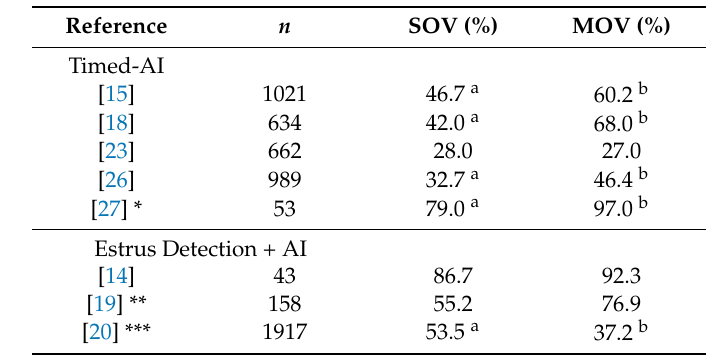
Table 2. Pregnancy per artificial insemination (P/AI) in cattle with single ovulations (SOV) versus multiple ovulations